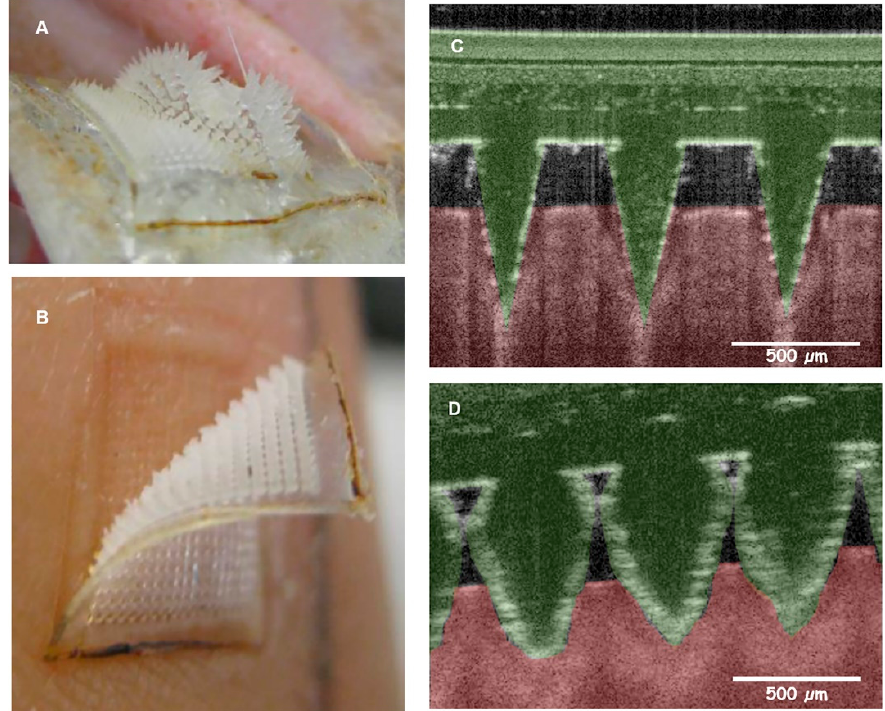
Figure 1. Hydrogel-forming microneedles for extraction of analytes from ISF. Figure obtained from Caffarel-Salvador et al. with permission [78]. A hydrogel forming microneedle array ( A ) before application into the skin and ( B ) after application where microneedles are swollen. Optical coherent tomography images show the microneedle arrays after skin insertion ( C ) before swelling, and ( D ) after swelling.